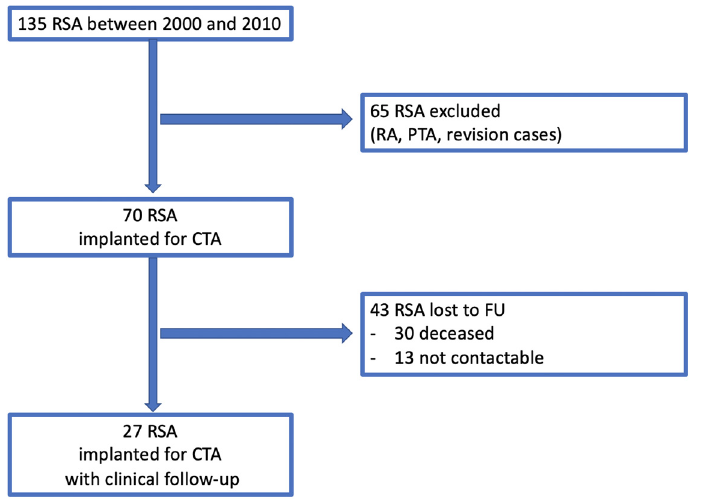
Figure 1. Flow chart. RSA = reverse shoulder arthroplasty; RA = rheumatoid arthritis; PTA = post traumatic arthritis; CTA = cuff tear arthropathy; FU = follow-up. Table 1. Demographics and characteristics of the study cohort. Age * = age at the time of implantation; SD = standard deviation; FU = follow-up.